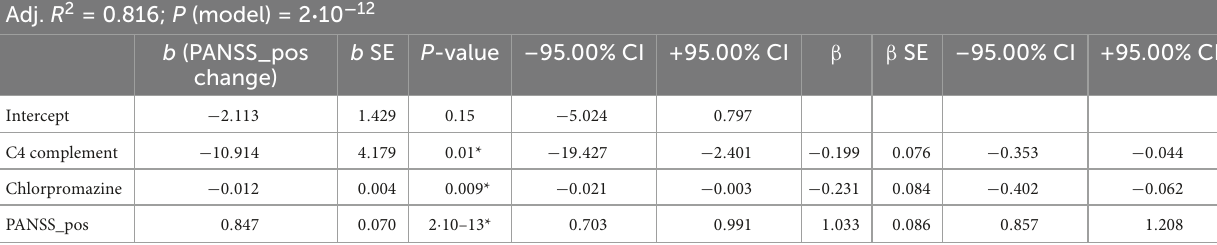
TABLE 2a Results of stepwise linear regression analyses for subscales of the Positive and Negative Syndrome Scale.